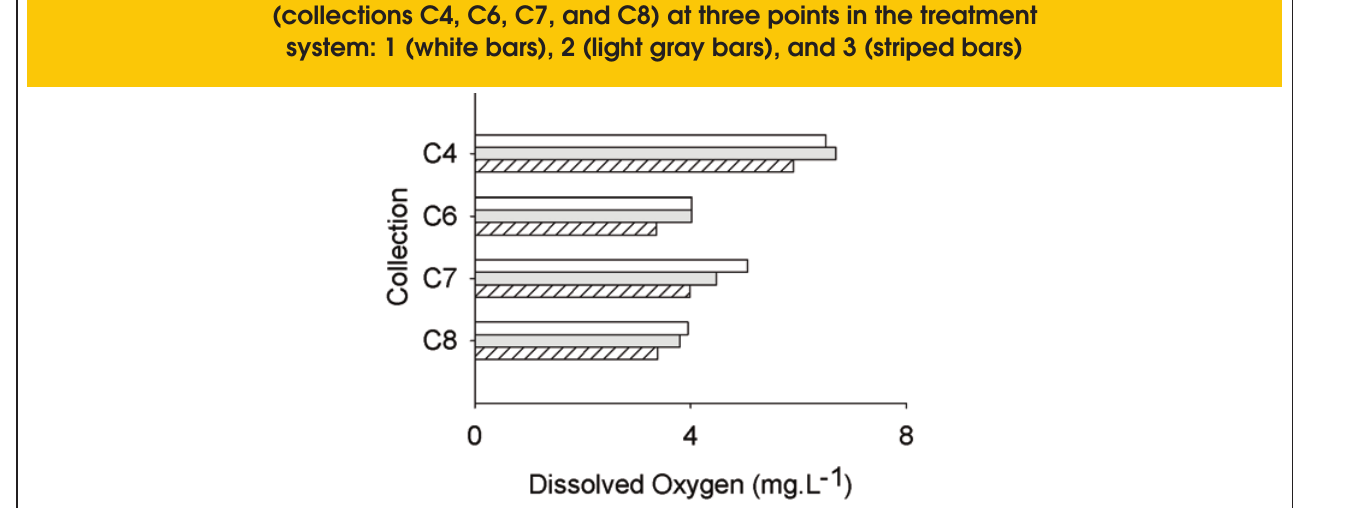
Figure 5 – Dissolved oxygen concentration of the samples collected in the rainy period (collections C4, C6, C7, and C8) at three points in the treatment system: 1 (white bars), 2 (light gray bars), and 3 (striped